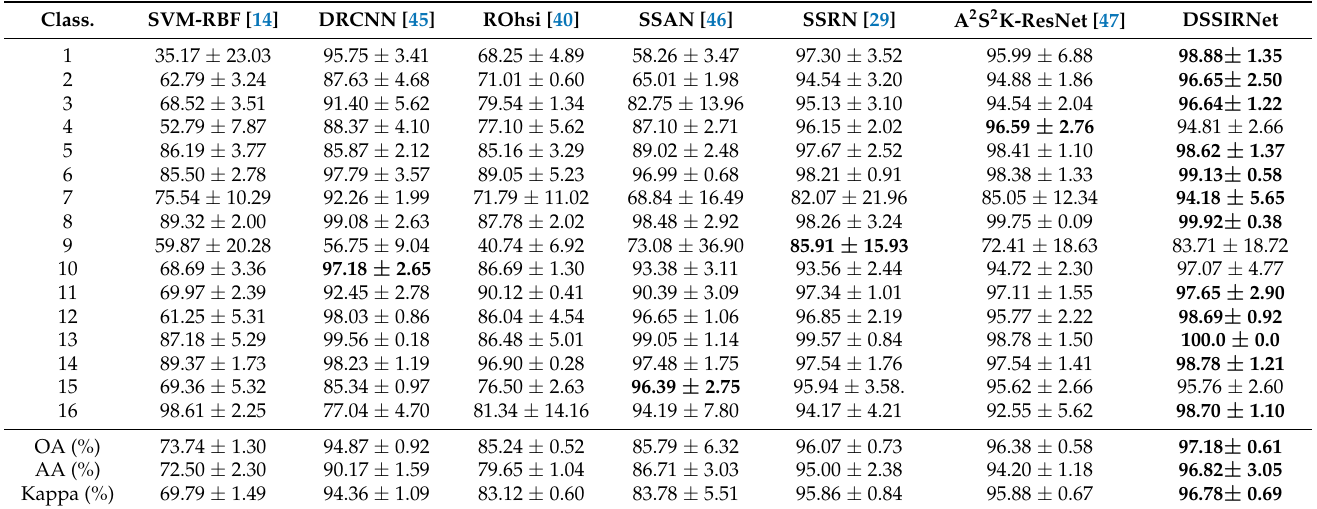
Table 3. Classification results of different methods on the IN dataset.